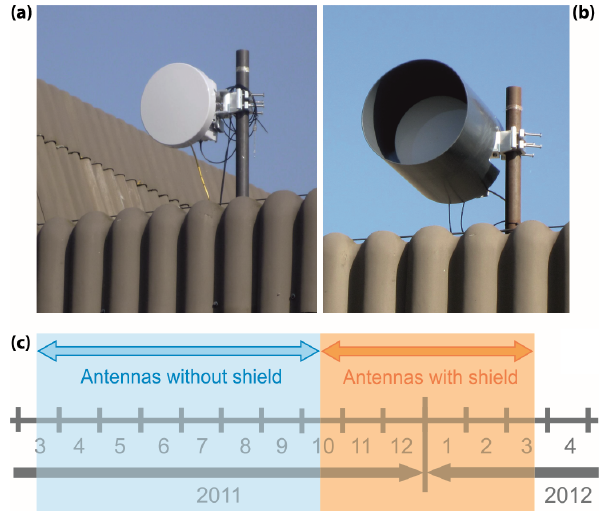
Figure 2. (a, b) Outdoor unit of the dual-polarized MINI-LINK and the antenna radome without (a) and with custom shield (b) . (c) Timeline of the operational period of the shielding of antenna radomes. Table 3. Location of the airport weather stations. Weather